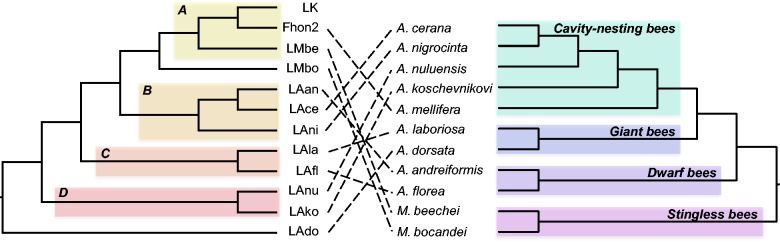
Tanglegram comparing the tree topologies of the L. kunkeei strains and their hosts. The tree topology and the microclusters (letters A–D) in the bacterial tree (left) correspond to the maximum-likelihood tree of the concatenated nucleotide alignment presented in figure 1b. The host phylogeny (right) has been taken from Arias and Sheppard (2005), Raffiudin and Crozier (2007), and Lo et al. (2010).